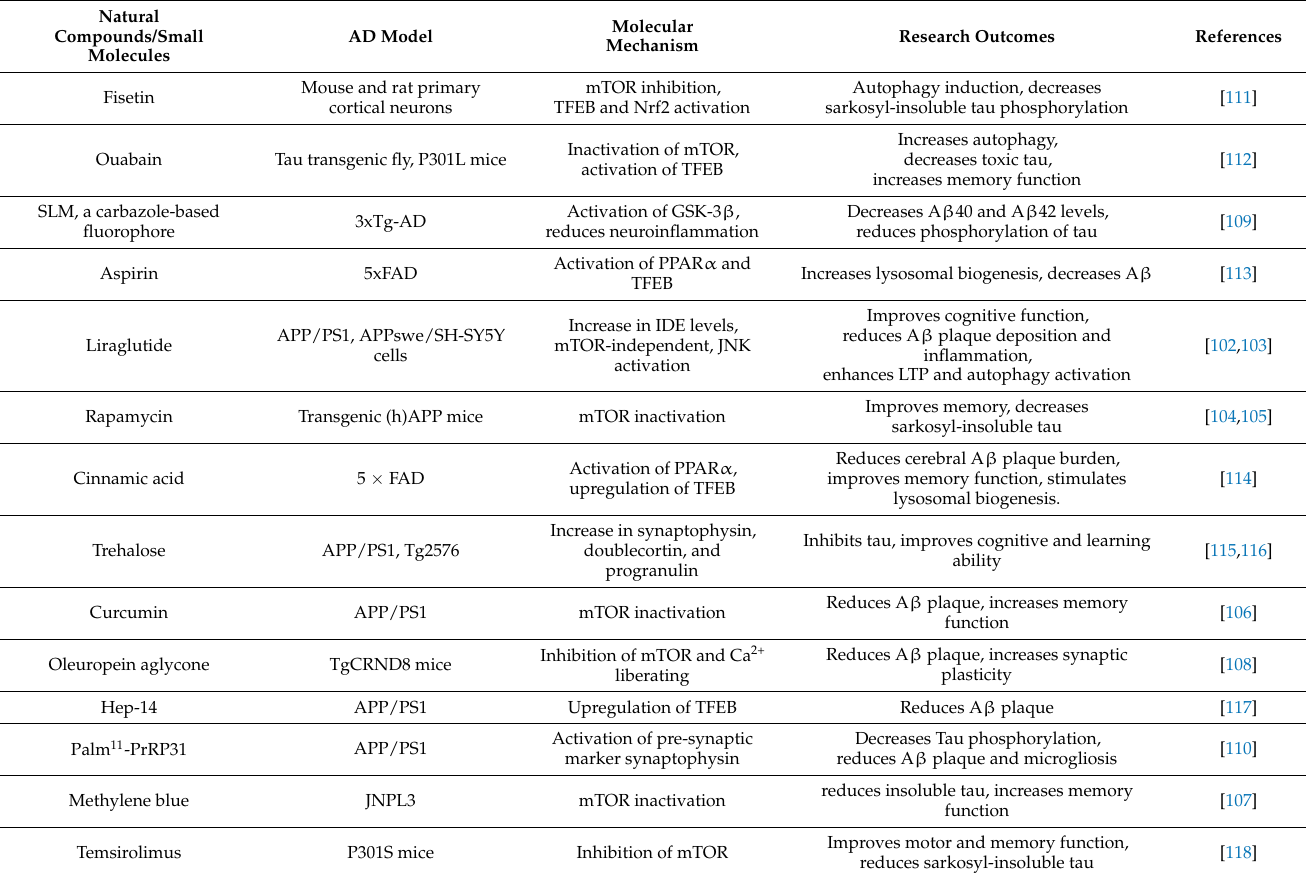
Table 1. Natural compounds and small molecules that modulate autophagic activity and control aggresome formation in AD